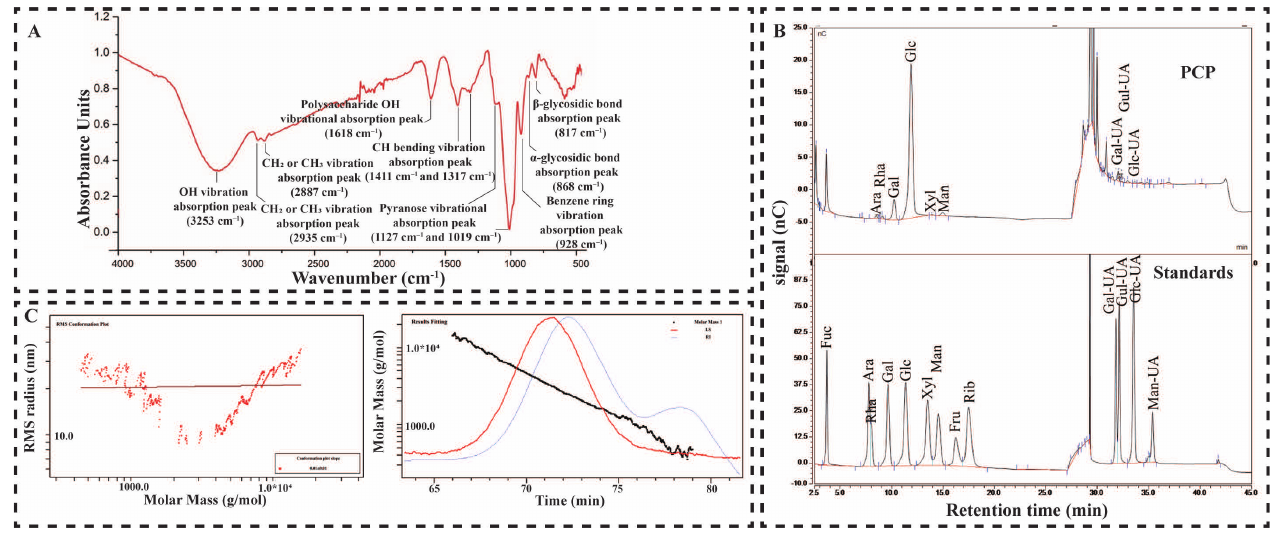
Figure 1. Material basis of PCP. The infrared spectrum of PCP ( A ). HAPEC ion chromatogram of PCP ( B ). HPGPC ion chromatogram of PCP ( C